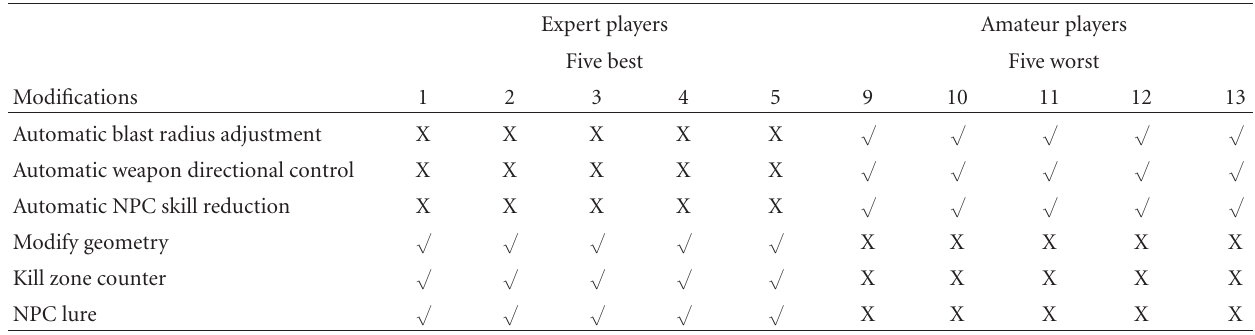
Table 5: Action recognition algorithm function in relation to player